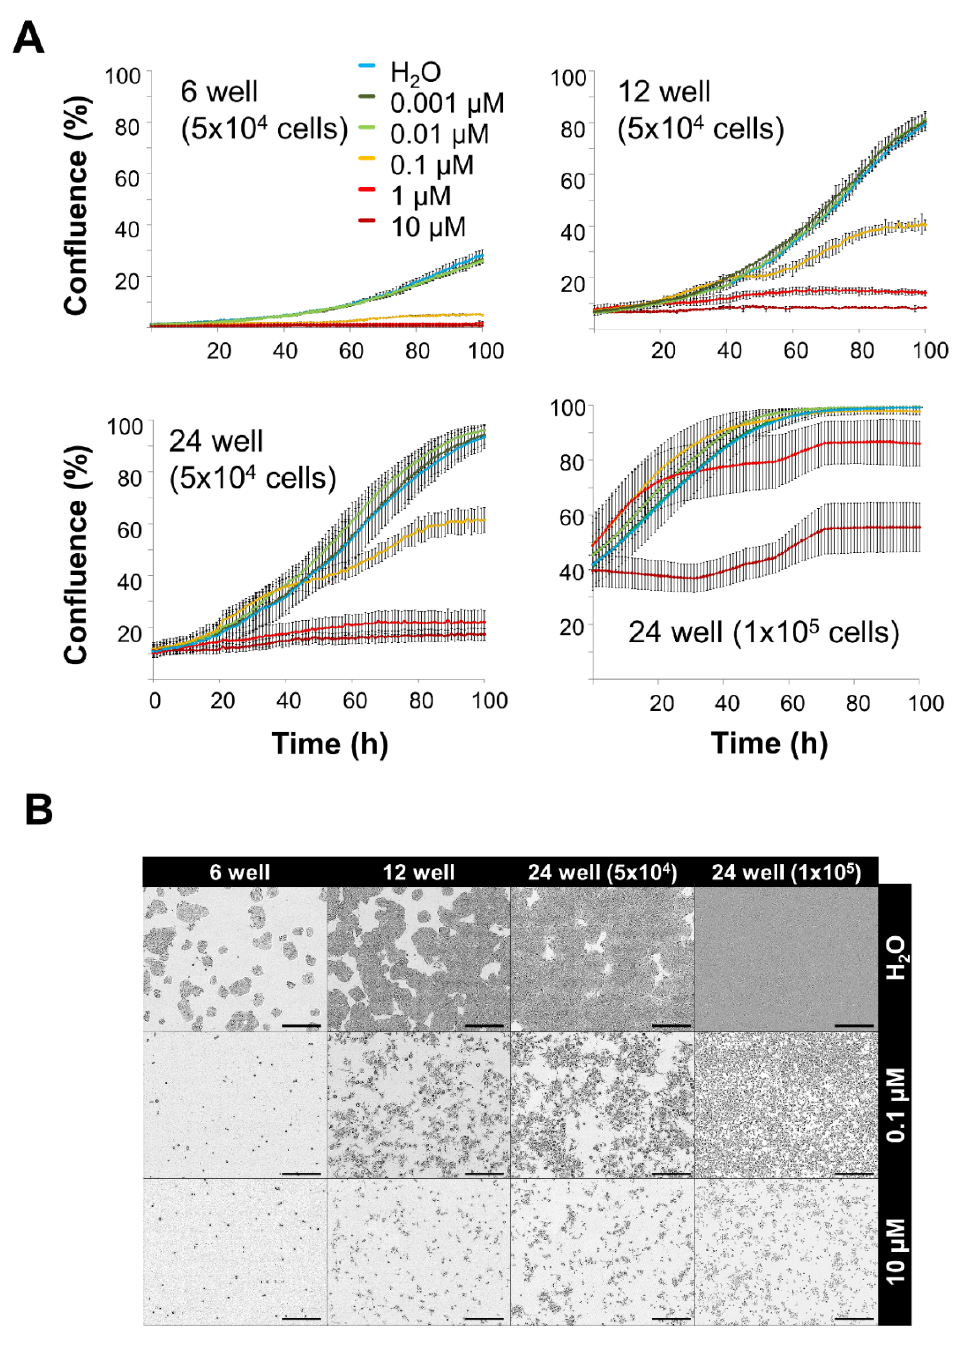
Figure 2. Toxicity of free mitoxantrone in monolayer cells depends on cell density. HT-29 cells were seeded into cell culture plates and treated with 0.001, 0.01, 0.1, 1 or 10 µM of free mitoxantrone (MTO). ( A ) Cell confluence of 5 ⋅ 10 4 HT-29 cells seeded in 6-, 12-, 24-well plates and 1 ⋅ 10 5 cells seeded in 24-well plates calculated from IncuCyte ® images. Shown are the mean values of 2–3 wells with 3–4 images per well with standard deviations. ( B ) Raw data files (pictures) from the IncuCyte ® system (t = 100 h). Scale bars refer to 400 µ m. Abbreviations: MTO: